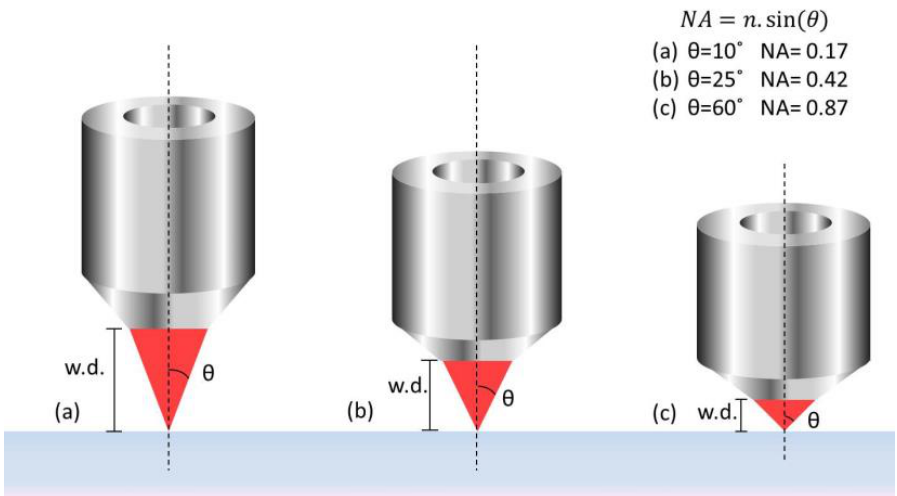
Figure 3. Light focusing through a microscope objective lens with different numerical aperture ( NA ) and working distance ( w.d. ) . ( a ) NA = 0.17, ( b ) NA = 0.42 and ( c ) NA = 0.87. Reproduced with permission [38]. Licensed under a Creative Commons Attribution 4.0 International license.